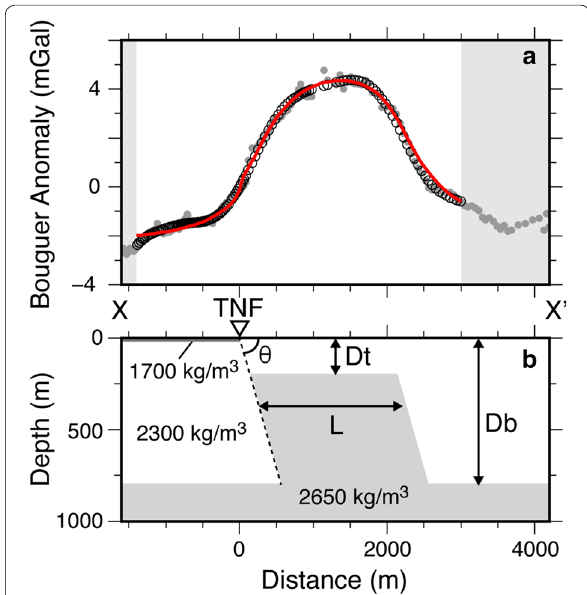
Fig. 3 a Comparison of observed Bouguer anomalies projected on the line X–X ′ across the TNF (gray circles), the smoothed and resampled ones (open circles), and those calculated from the optimum density structure using the 2D Talwani’s method (red line). Data in the gray areas are not used for the calculation. b Schematic view of the model parameters of the 2D density structure. A triangle shows the location of the surface trace of the TNF (at distance A dark gray layer near the surface represents the sediment layer with 20 m